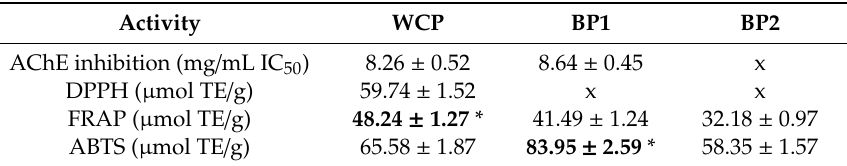
Table 5. Acetylcholinesterase (AChE) inhibitory and radical scavenging activities of polysaccharides isolated from H.